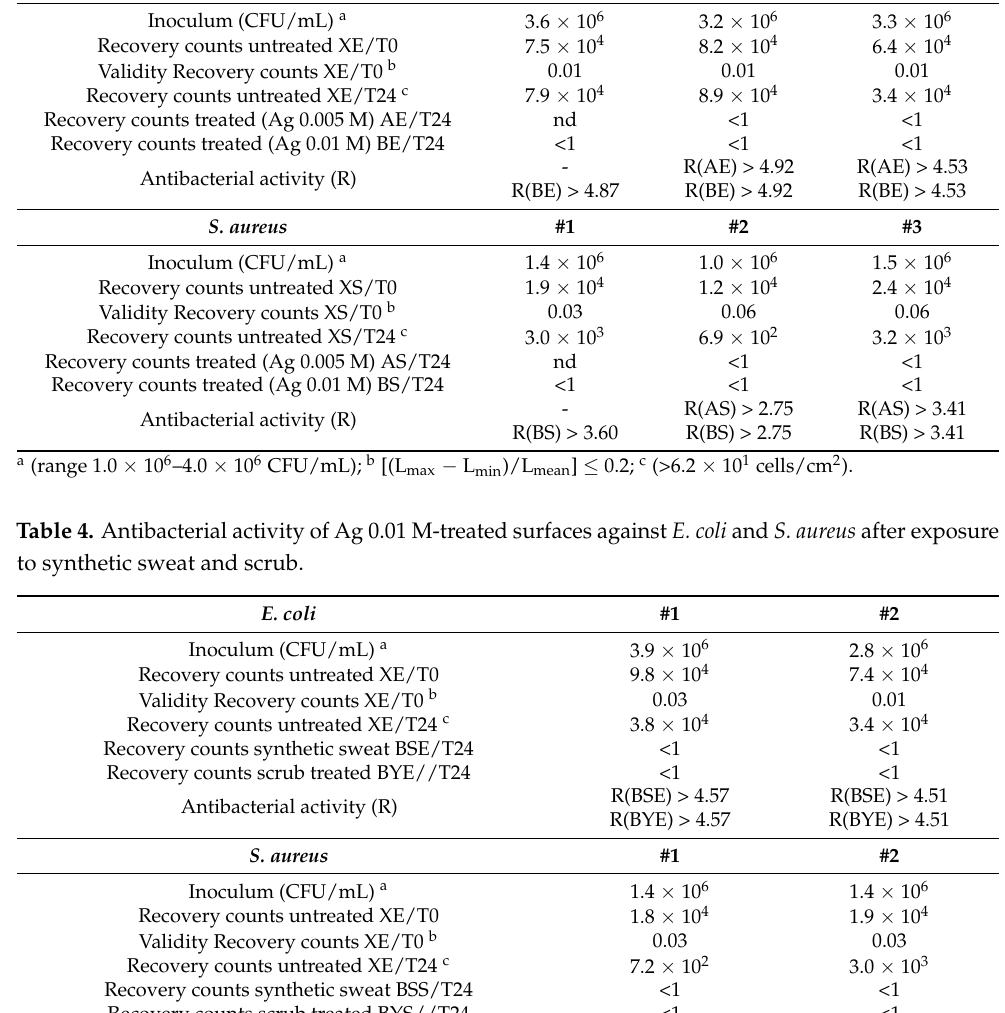
Table 3. Antibacterial activity of AgNO 3 -treated surfaces against E. coli and S. aureus . E. coli